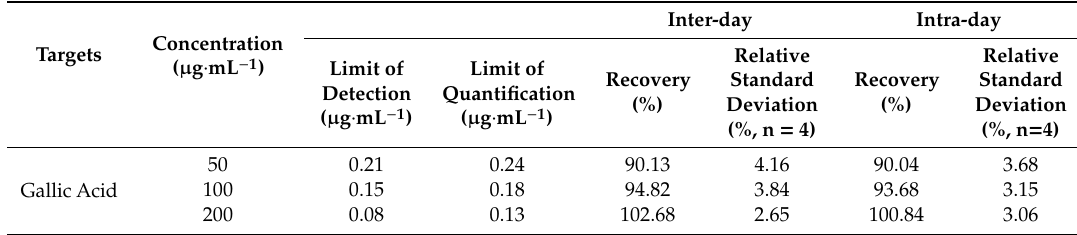
Table 1. Intra-day and Inter-day precisions and accuracy of GA.